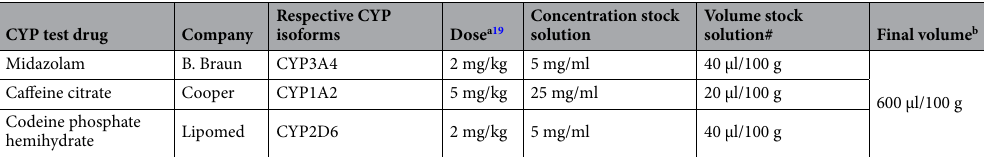
Table 1. Each drug was diluted in 200 µl of sterile water resulting in a concentration of 1 mg/ml for midazolam and codeine, and 2.5 mg/ml for caffeine. The three aliquots were mixed resulting in a total volume of 600 µl. The volume to be applied (180 µl/30 g bwt) was calculated based on the body weight of the individual mouse. Route of drug application. The drug cocktail was administered via intraperitoneal injection. We preferred this method compared to oral or intravenous injection for three reasons: first to reduce the stress for the animal caused by gavage; second, to reduce the risk of complications following intravenous injection into the penis vein; third, to reduce the risk of drug contamination upon injection and sampling from the same site, the tail vein thereby possibly causing false-positive results 53 . Sacrifice and sampling. Animals were subjected to repeated micro-blood sampling at ten scheduled time points over six hours (before injection, 15 min, 30 min, 1 h (h), 1.5 h, 2 h, 2.5 h, 3 h, 4 h, 6 h). Samples were col- lected from the tail vein using heparinized calibrated end-to-end capillaries tubes (Minicaps, Hirschmann) with a volume of 9 μl (accuracy 0.5%, CV < 1%). Animals were sacrificed 24 h after injecting the drug cocktail using an overdose of isoflurane with exsanguination. Liver tissue samples were collected from four different liver lobes (left lateral lobe, right median lobe, right superior lobe, and inferior caudate lobe), and were subjected either to formalin fixation and paraffin embedding or were snap-frozen and cryopreserved at -80 °C until used.